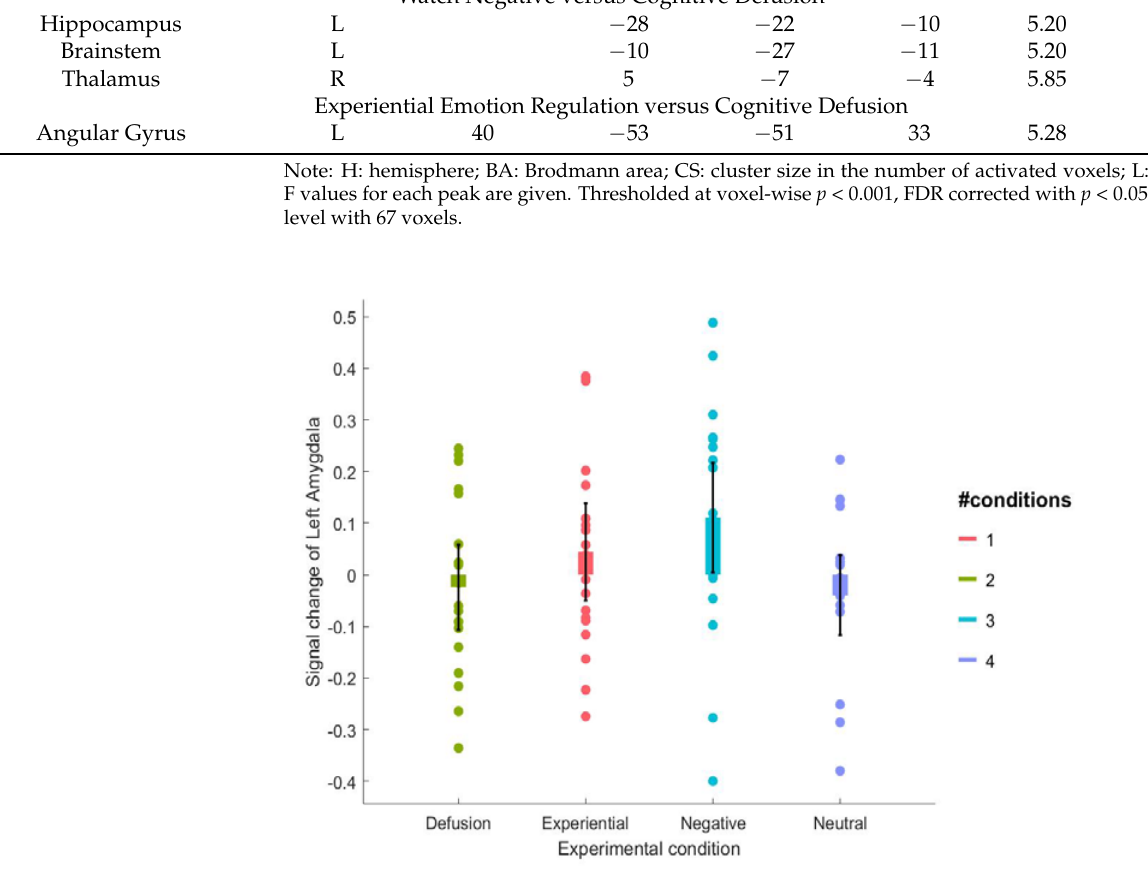
Figure 3. Signal change of left amygdala under the four experimental conditions.